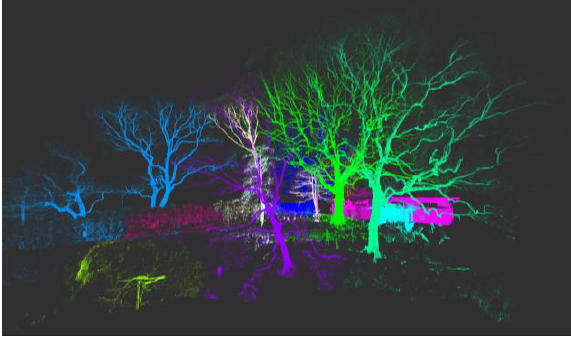
Figure 6. Segmentation using Computree